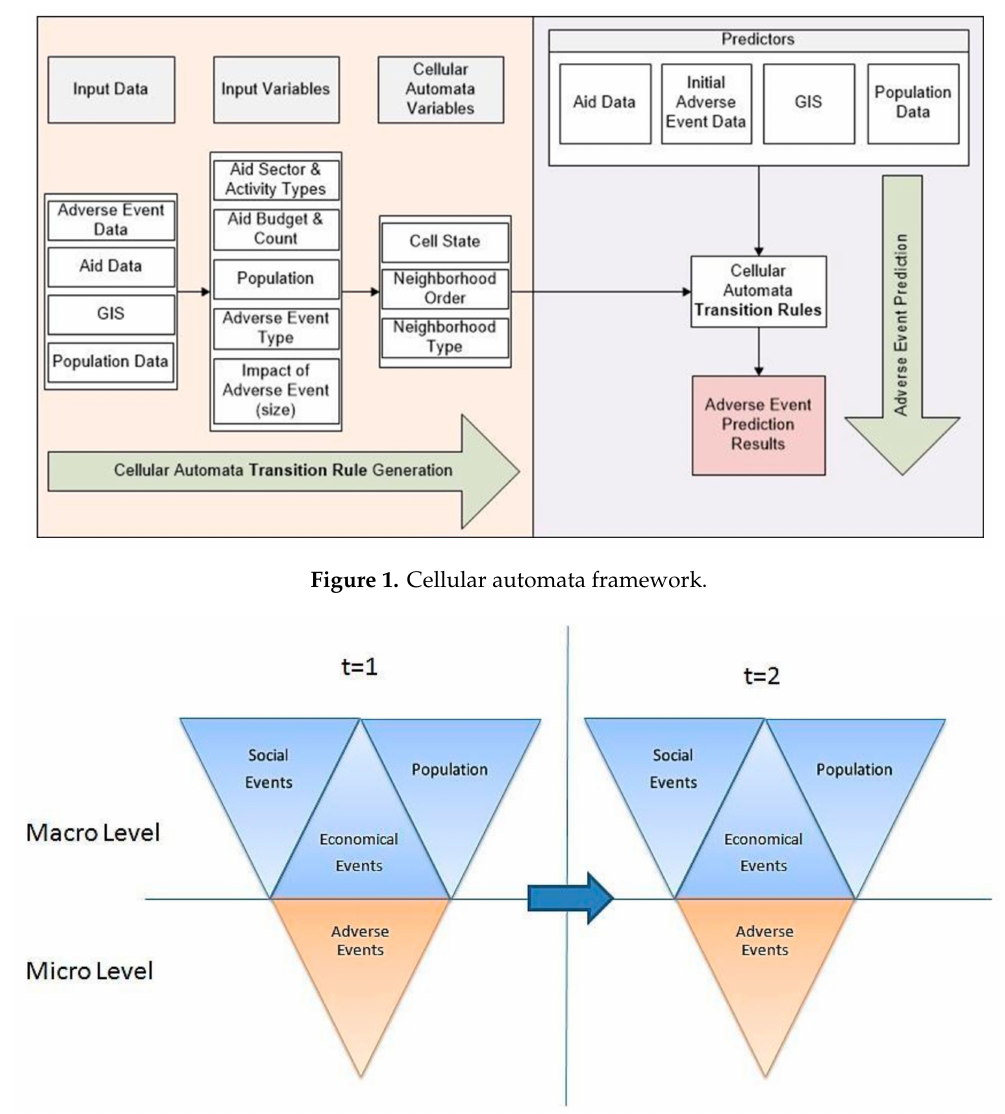
Figure 2. Cellular automata